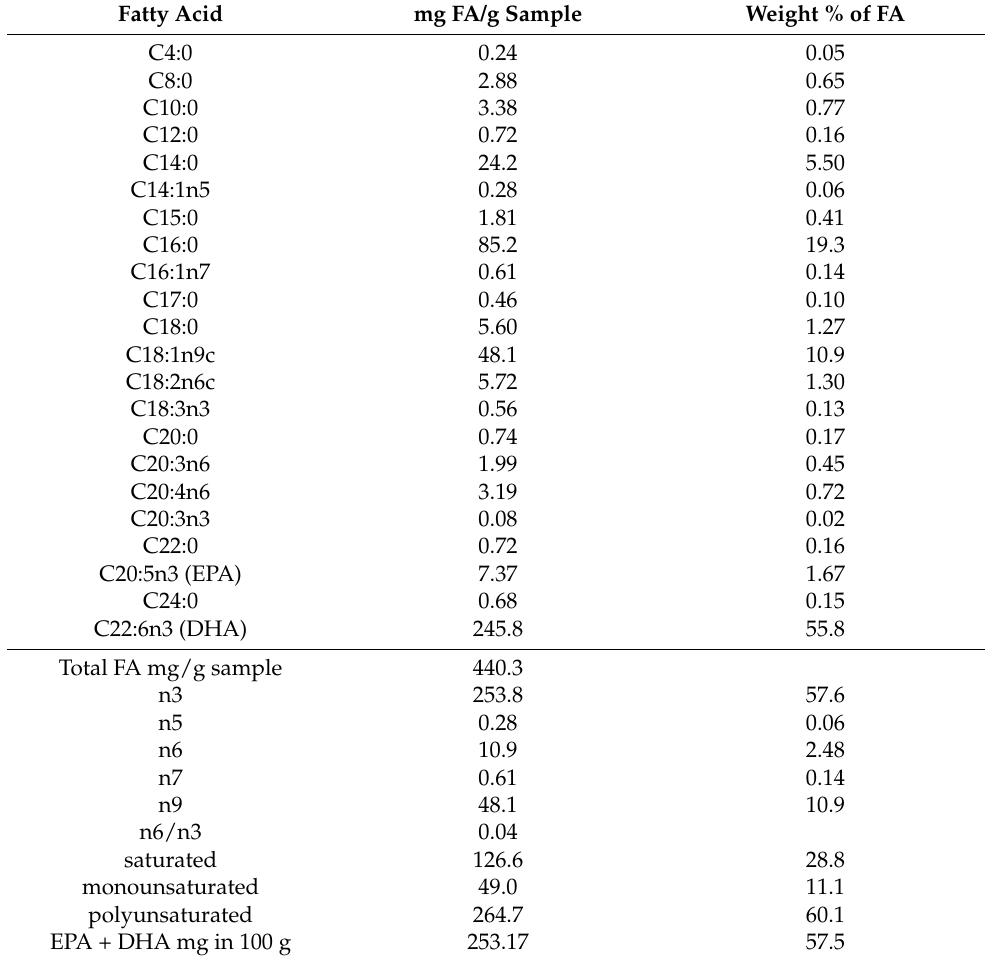
Table 2. Quantitative and qualitative fatty acid composition of the S17-P100 food additive.